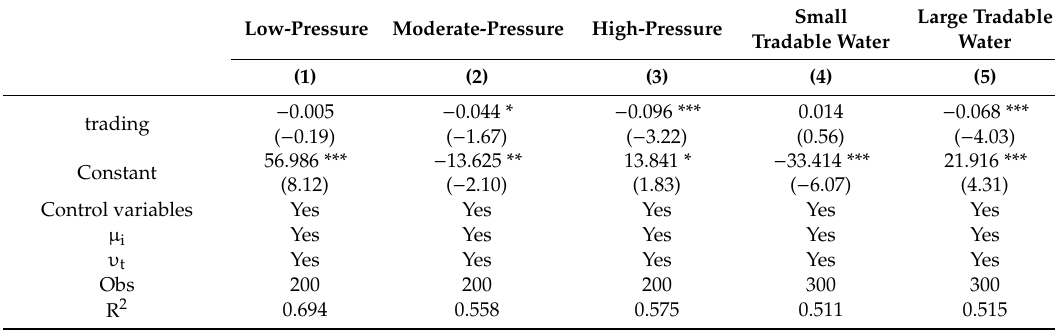
Table 5. The result of heterogeneity